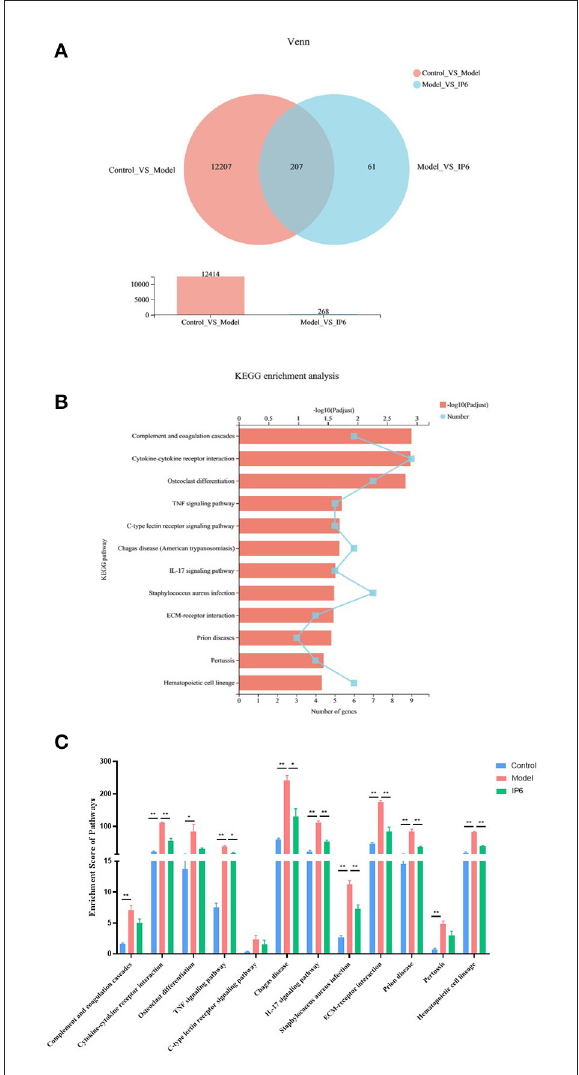
FIGURE3 Partly signaling pathways changes in the cecum of Model mice be reversed by IP6-treated. (A) Venn Plot of the DEGs between the Control group vs. Model group and Model group vs IP6 group. (B) KEGG enrichment analysis line chart of 156 DEGs (Adjusted P < 0.05). (C) Enrichment scores of 12 KEGG signal pathways. Data were analyzed using one-way ANOVA followed by the Tukey post hoc test for C. n = 3 per group, * P < 0.05; ** P <